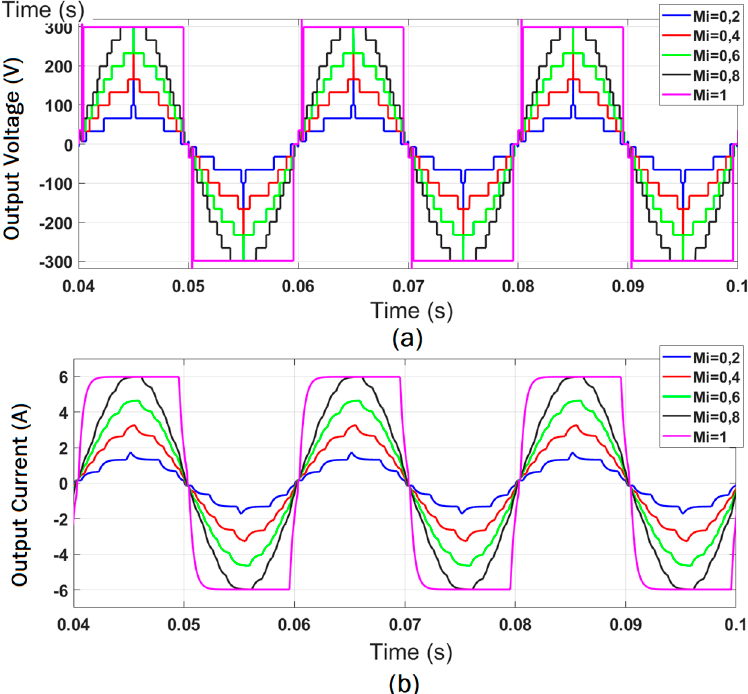
Figure 11. The effect of modulation index variations on the output currents and voltages of 19-level MLI employing the SPBO method.